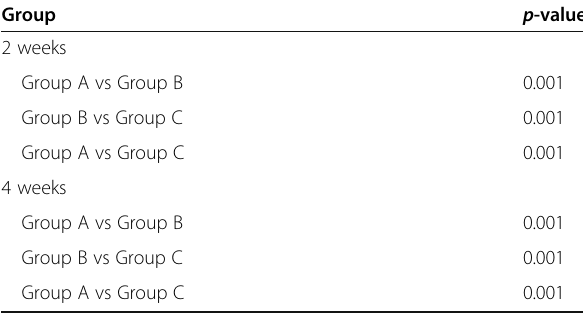
Table 3 Statistical analysis of sciatic nerve function index Group p